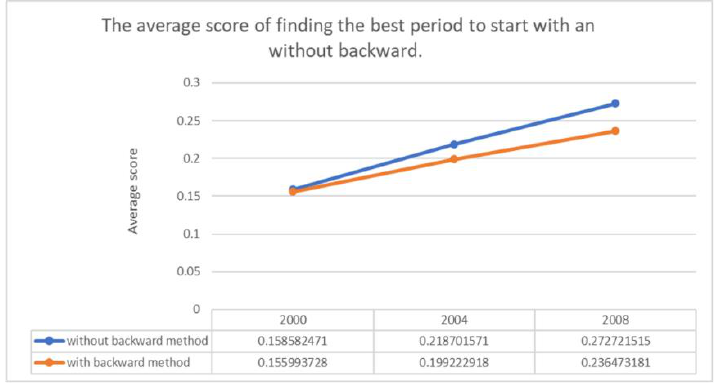
Figure 14. Comparison of an average score with and without backward in three different years.